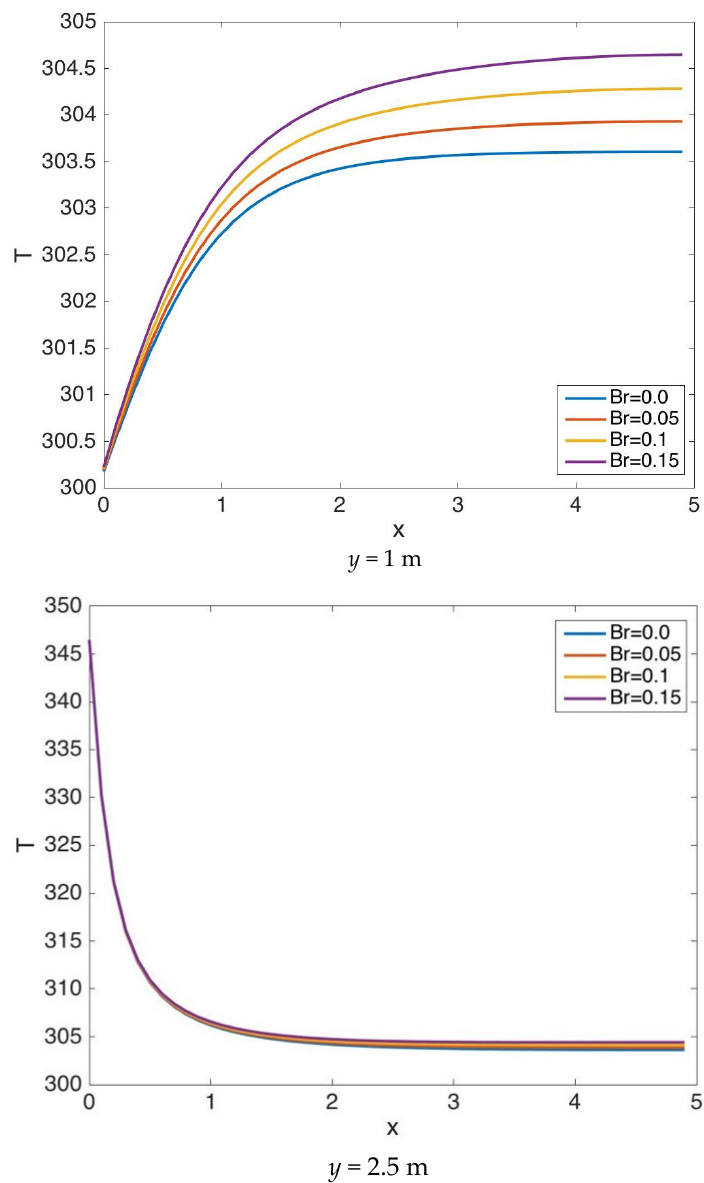
Figure 11. Temperature profiles against x -axis at y = 1 m, 2.5 m for various values of Br of Case 2.